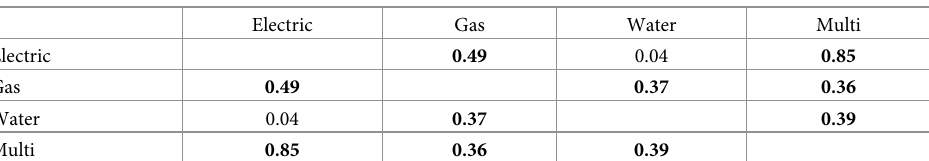
Table 14. Utilities